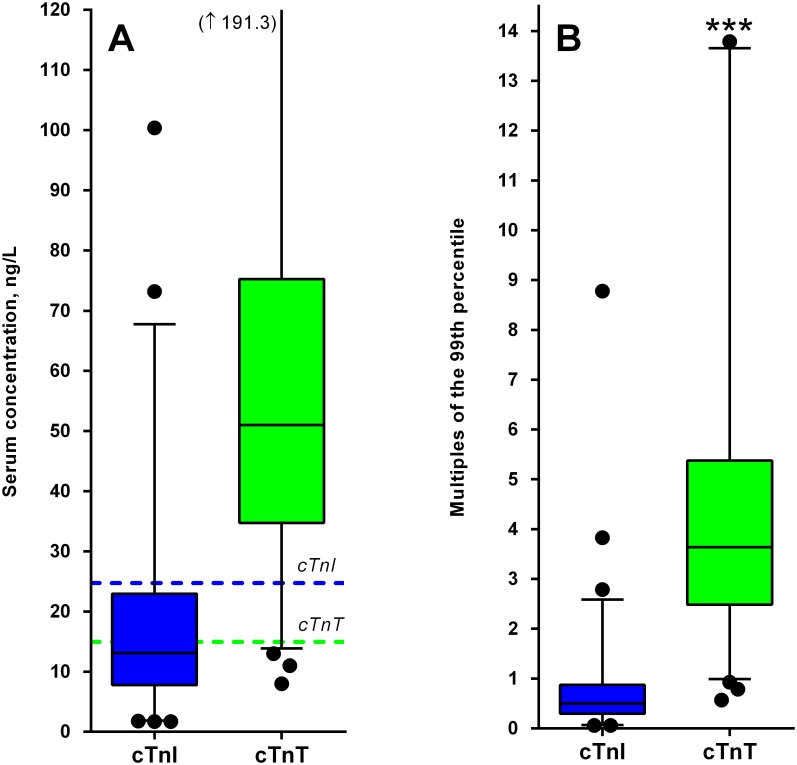
Distribution of serum cTnI and serum cTnT.(A) Box Whisker plot of serum cTnI and cTnT concentrations indicating the median, interquartile range, 2.5th and 97.5th percentile. The dotted lines represent the 99th percentile cut-off for a positive test. (B) Box and Whisker plot of serum cTnI and cTnT expressed as multiples of the 99th percentile. ***; p<0.001.